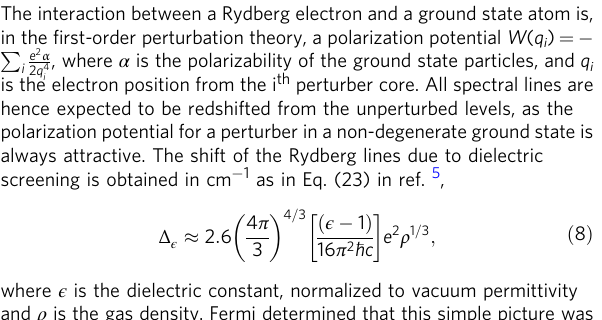
Fig. 1 Ultracold Rydberg molecules and macrodimers. Schematics of Rydberg molecular electronic density and potential energy curves; a depicts an ultralong-range Rydberg molecule while b shows a Rydberg macrodimer. The ultralong-range Rydberg molecule consists of a ground state atom or a polar molecule embedded in the electronic orbital of the Rydberg atom. The potential energy curves exhibit oscillations. A Rydberg macrodimer consists of two Rydberg atoms interacting via macroscopic electrostatic multipolar interactions. The Rydberg electron orbitals (~ 0.1 μ m) in this schematic are not shown in proportion to the separation Box 1 | Lines redshift in a dielectric medium The interaction between a Rydberg electron and a ground state atom is, in the fi rst-order perturbation theory, a polarization potential W ( q i ) = − P e 2 α , where α is the polarizability of the ground state particles, and q i i 2 q 4 i is the electron position from the i th perturber core. All spectral lines are hence expected to be redshifted from the unperturbed levels, as the polarization potential for a perturber in a non-degenerate ground state is always attractive. The shift of the Rydberg lines due to dielectric screening is obtained in cm − 1 as in Eq. (23) in ref. 5 ,